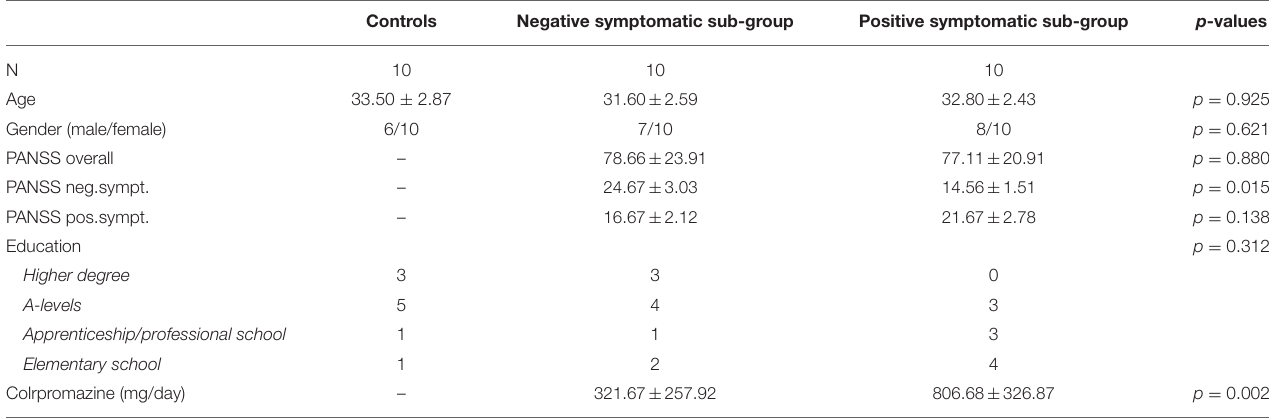
TABLE 1 | Demographic and clinical characteristics ( p -values represent the significance of the performed Kruskal–Wallis tests between groups, except gender, and education, which were tested with chi-square tests).